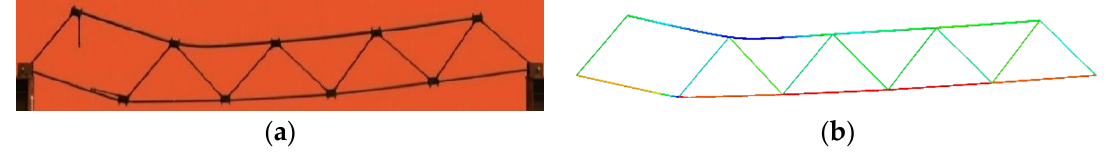
Figure 6. Balanced configuration after W2 failure: ( a ) Test truss, ( b ) FE model.